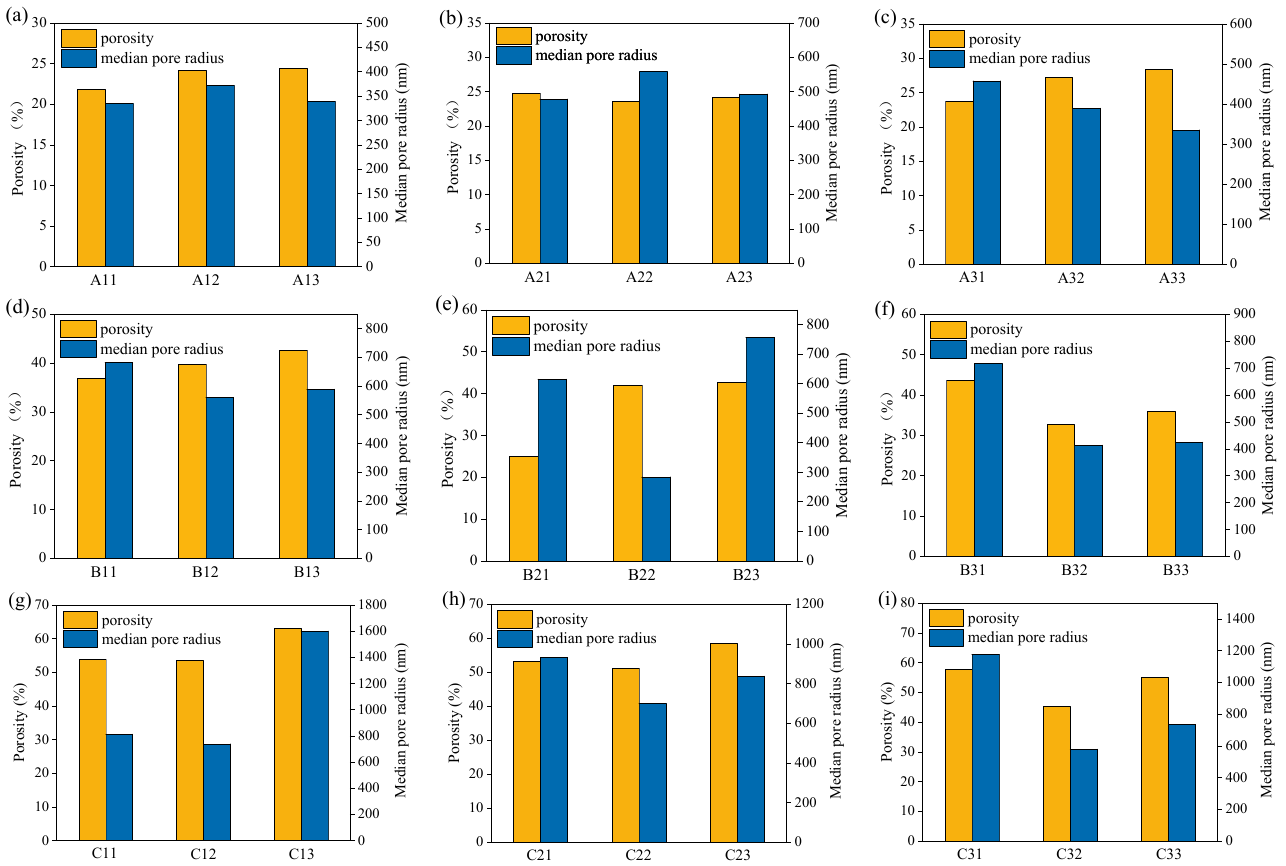
Figure 3. Physical properties of porous alumina samples measured using a mercury intrusion po-